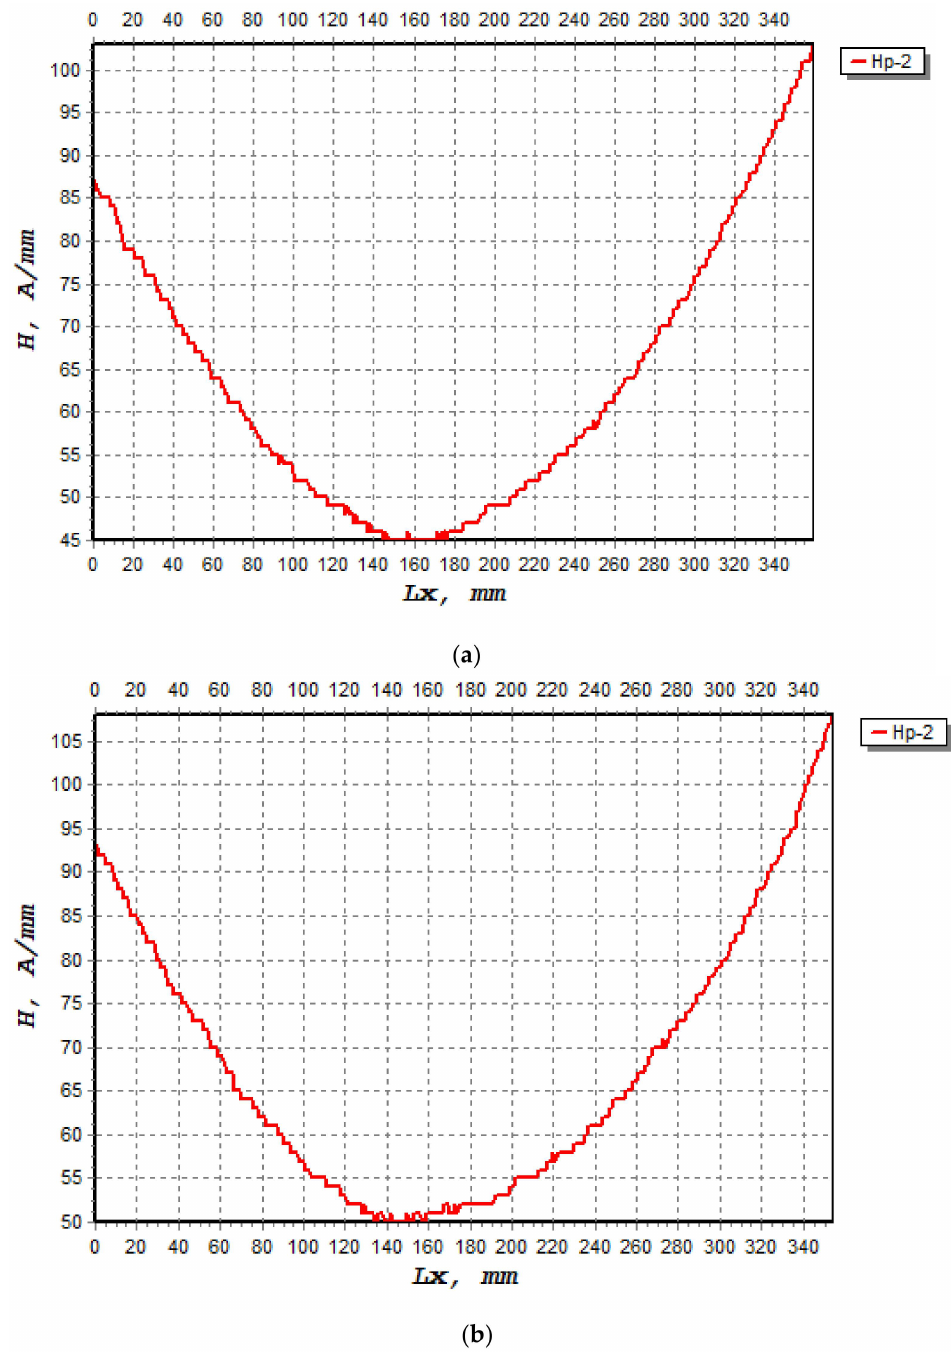
Figure 7. The component signals, H(p), that occurred on the beam when subjected to cyclic loading; Hp-2 during load cycles ( a ) 1400, ( b )